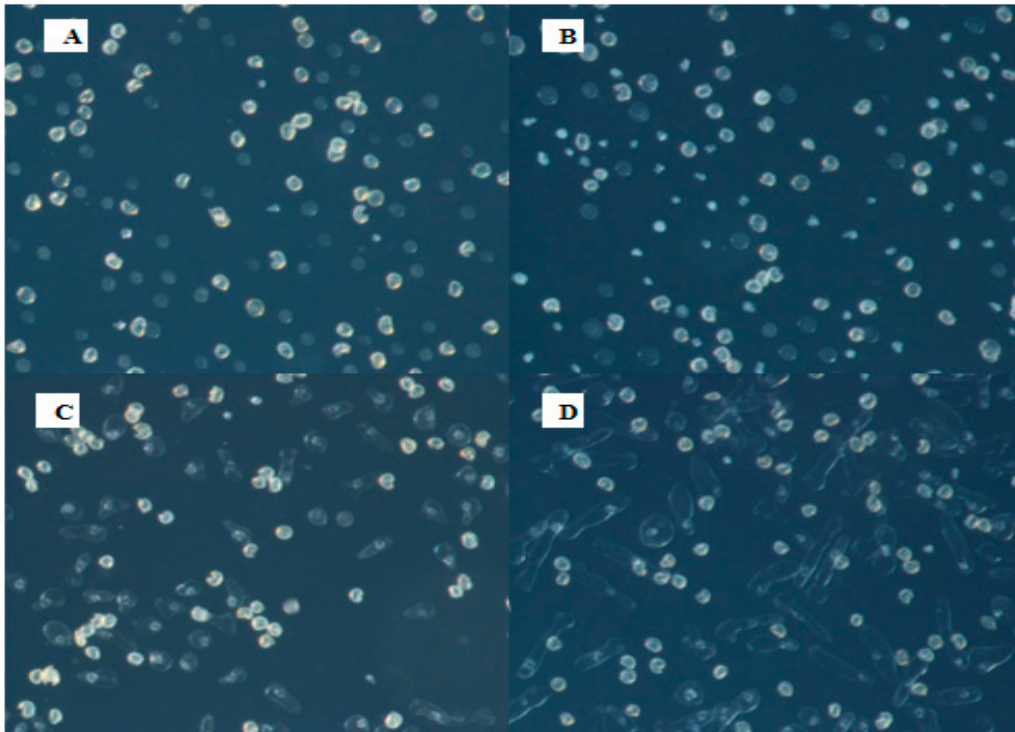
Figure 3. In vitro germination of the pollen and tube growth at different time of incubation. The four